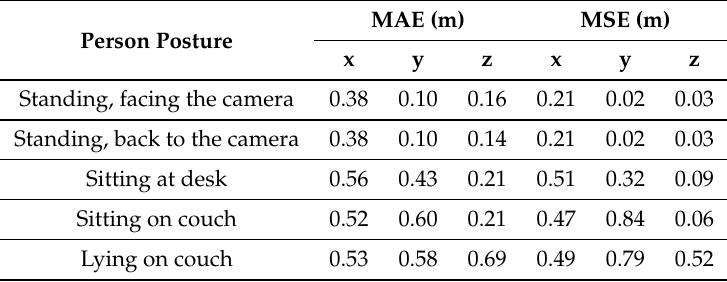
Table 9. Errors of the coordinates estimation module by person postures.